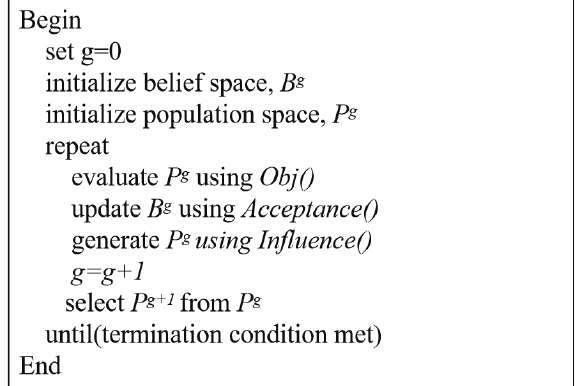
Figure 2. Pseudo-code of cultural algorithm.